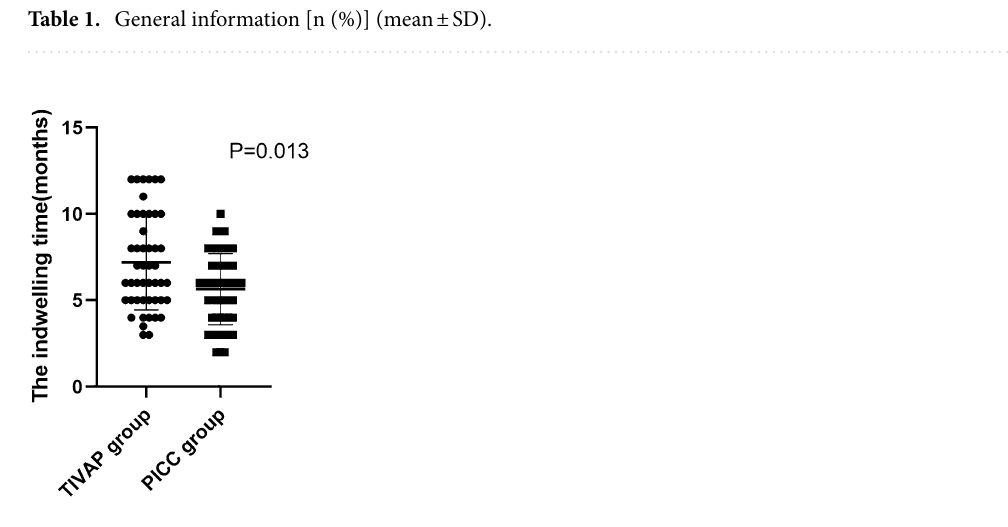
Figure 3. The comparison of the indwelling time in the TIVAP group and in the PICC group. The indwelling time was calculated monthly. The indwelling time in the TIVAP group is significantly longer than that in the PICC group ( P < 0.05).